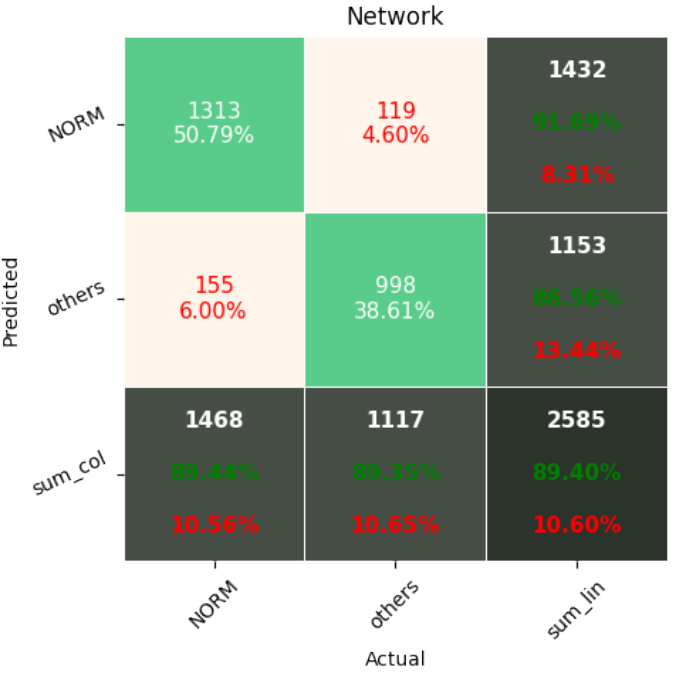
Figure 12. Confusion Matrix for softmax-based classification (2 classes).